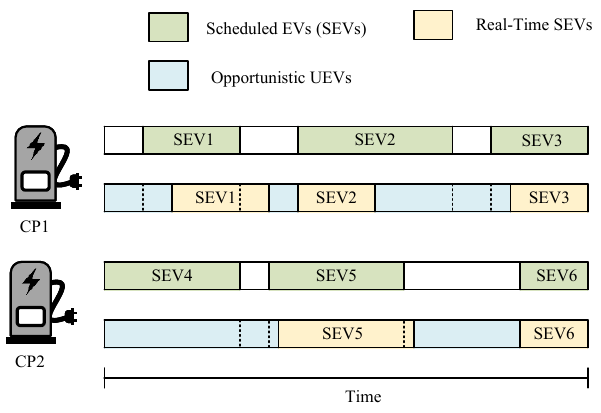
Figure 2. Utilization of charging resources by